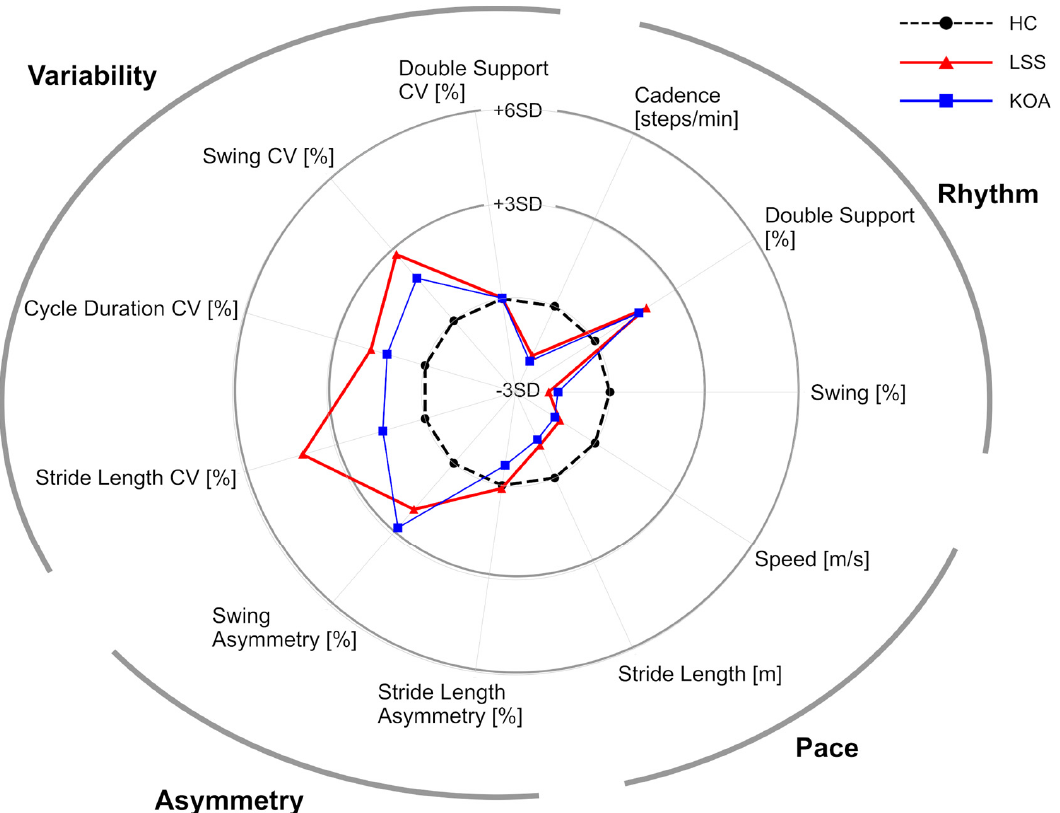
Figure 1. Radar plot illustrating the gait parameters extracted from the analysis of the entire 6MWT. The central black dots with connecting dashed lines represent HC data. This is compared to LSS (blue squares and lines) and KOA (red triangles and lines) with deviation along the axis radiating from the center of the plot representing the standard deviations (range; from − 3 SD to +6 SD) from HC. (HC; healthy control, LSS; lumbar spinal stenosis, KOA; knee osteoarthritis, CV; coefficient of variation, SD; standard